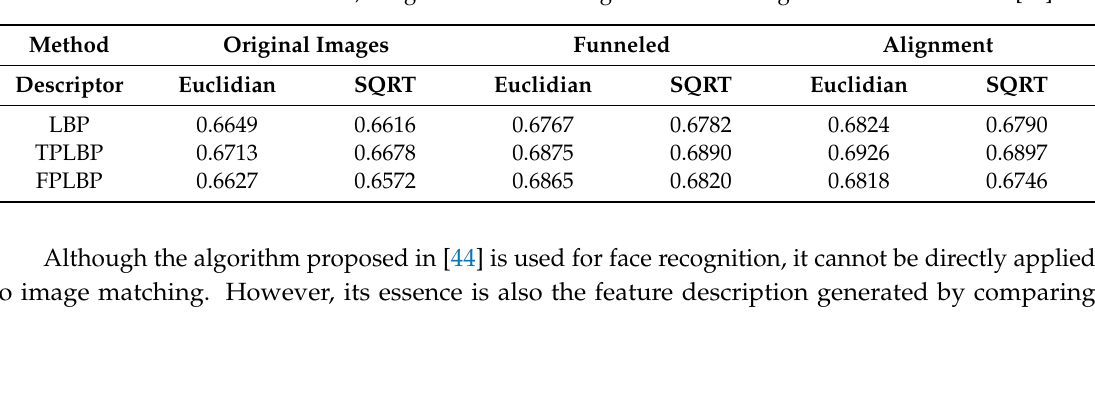
Table 1. Mean scores on the LFW, image-restricted training benchmark using Euclidean similarities